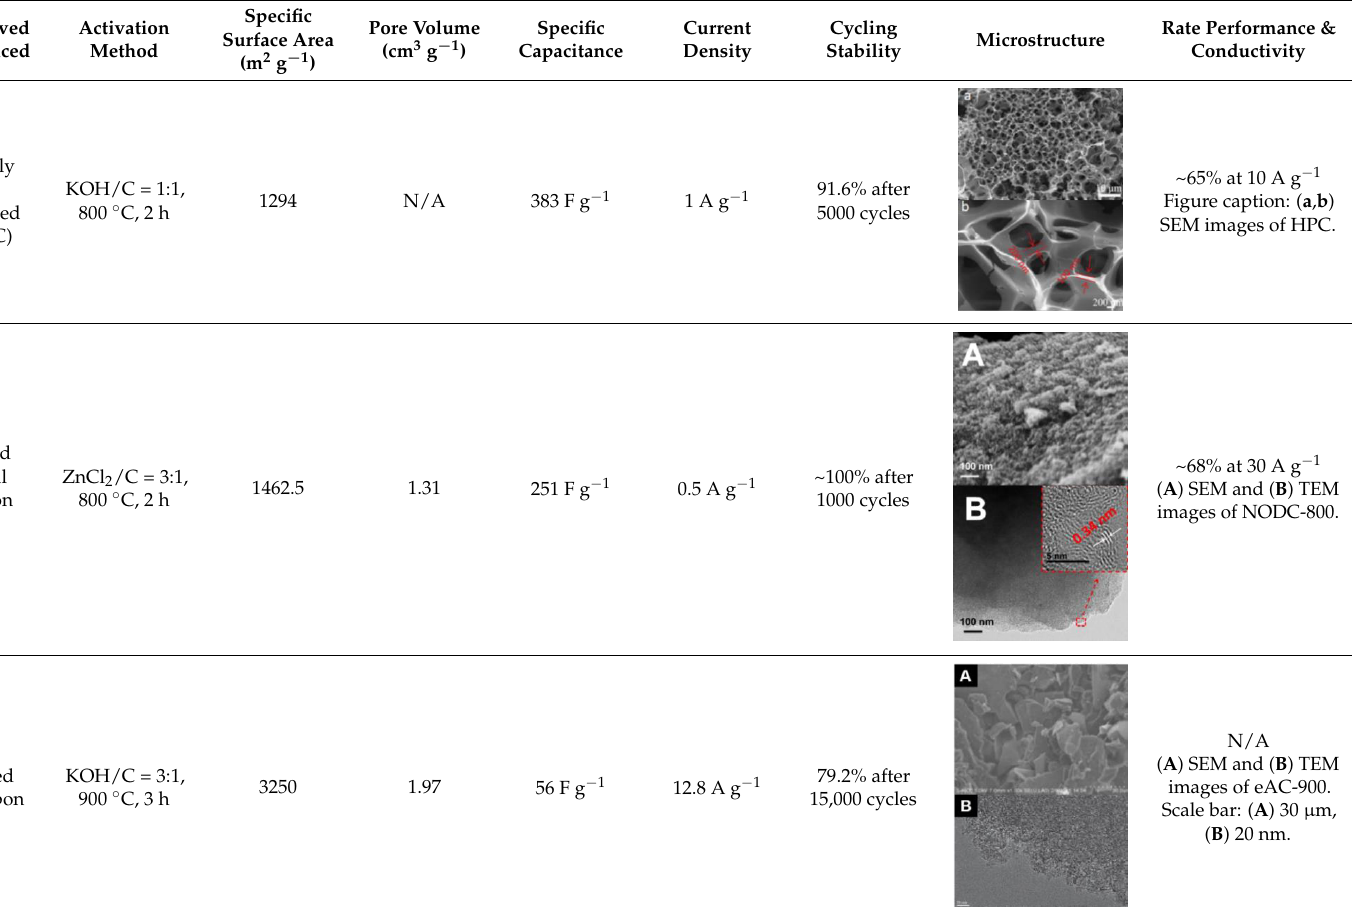
Table 8. The supercapacitor performance and the related structural parameters of biomass-derived carbon produced from different plant-, fruit-, microorganism- and animal-based precursors (the rate performance of the materials are referred to the percentage remain of the specific capacitance shown in the sixth column at the elevated current density).